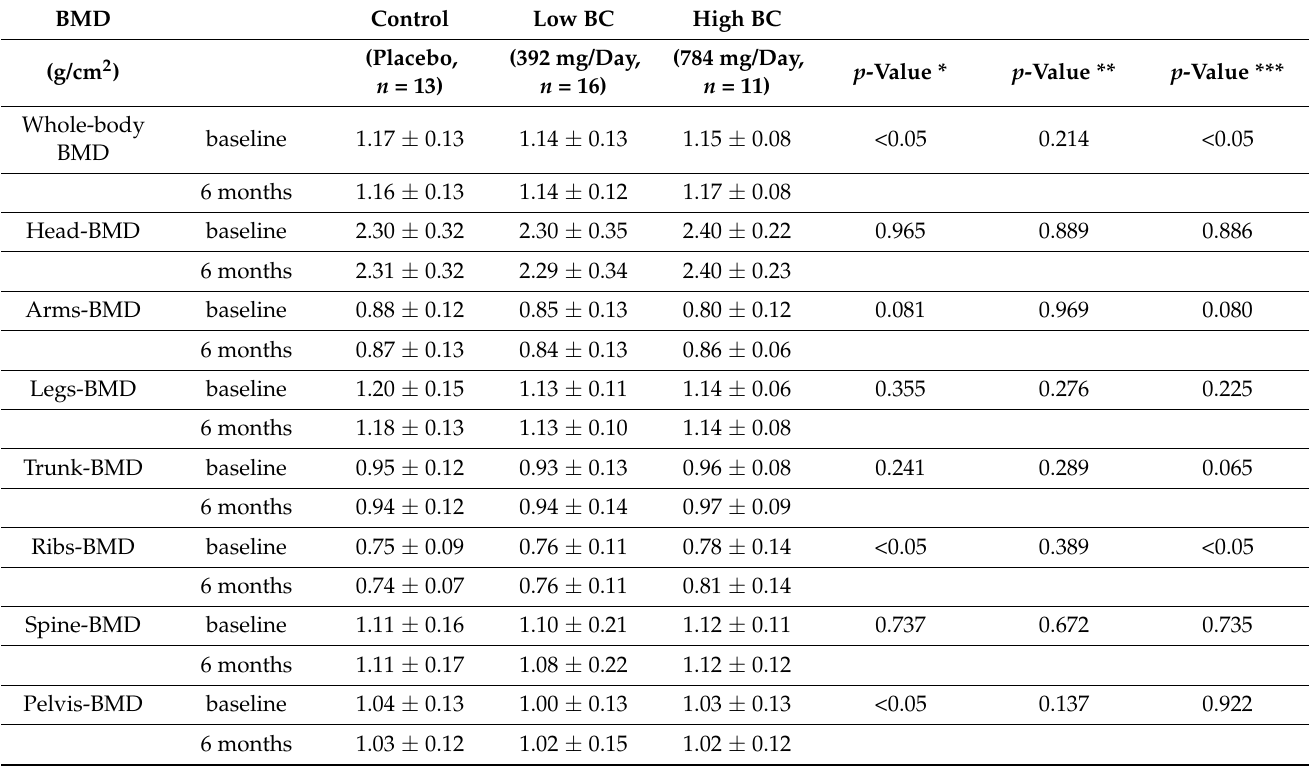
* Significance of differences were assessed using repeated-measures ANOVA with treatment as levels of between- subjects factors and time as levels of within-subjects factors. ** Significance of differences were assessed using repeated-measures ANOVA only for control and low BC groups. *** Significance of differences were assessed using repeated-measures ANOVA only for control and high BC